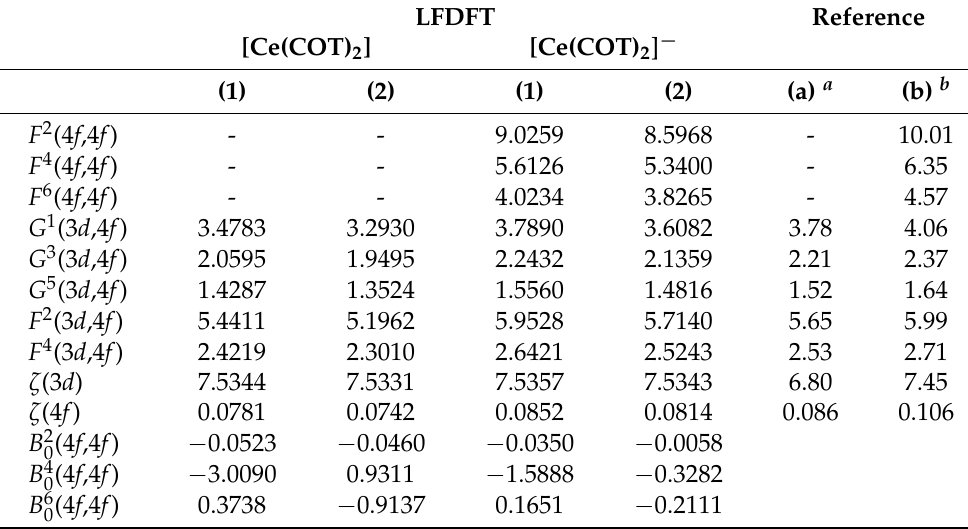
Table 3. Calculated parameters of the ligand-field Hamiltonian for the [Ce(COT) 2 ] and [Ce(COT) 2 ] − systems: Slater–Condon integrals, spin-orbit coupling constant and the ligand-field potential in terms of the Wybourne-normalized crystal-field parameters (in eV) obtained from LFDFT using the PBE (1) [37], and PBE0 (2) [39,40] functional, compared with reference data taken from the litterature: average free-ion parameter for La 3 + (iso-electronic to Ce 4 + ) (a) and Ce 3 +